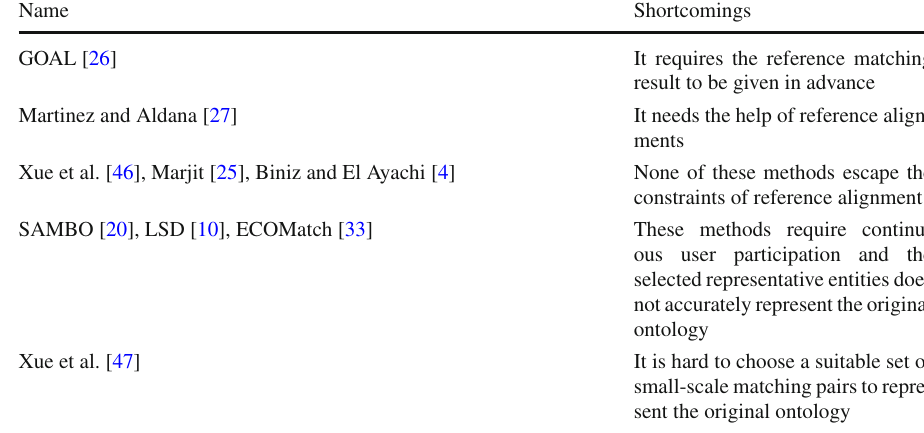
Table 1 Reference alignment and partial reference alignment-based matching systems and their